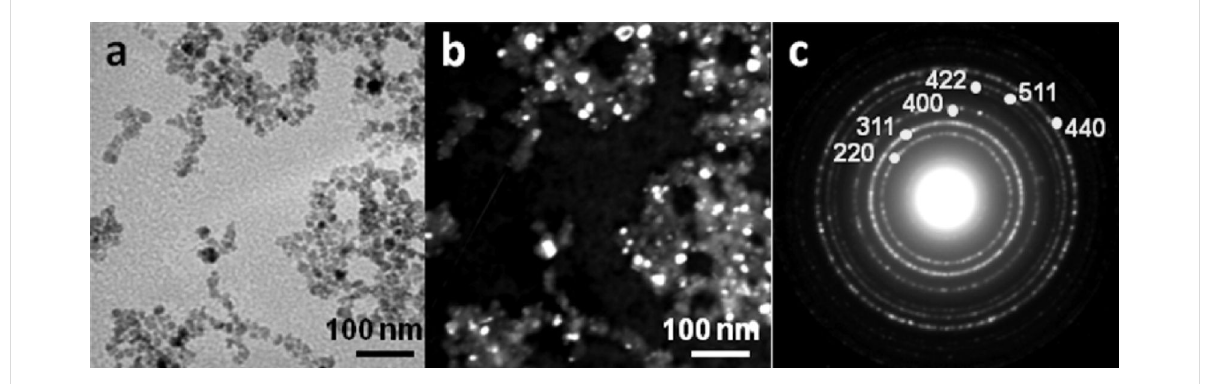
Figure 2: Bright field (a) and dark field (b) transmission electron microscopy (TEM) images and diffraction pattern (c) of USM nanoparticles.